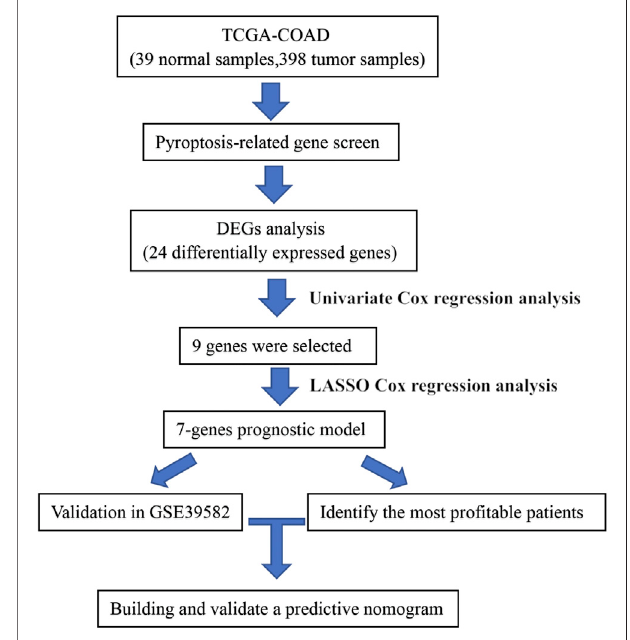
TABLE 1 | Primer sequences of genes in the risk model used for qPCR.